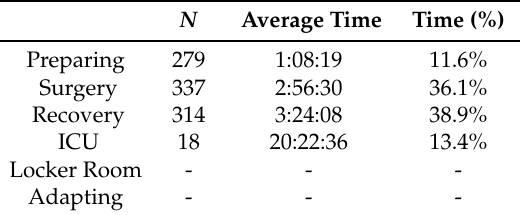
Table 5. Hospitalized patients.